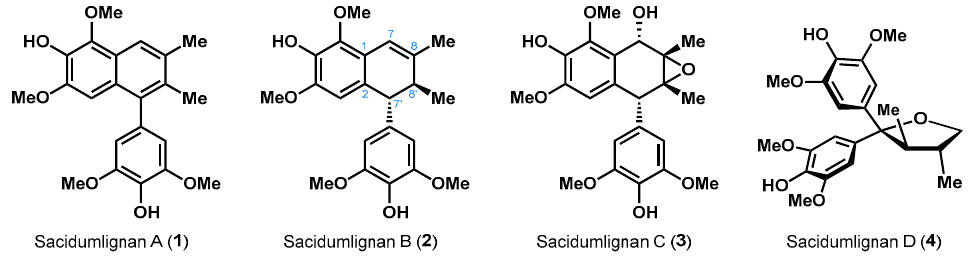
Figure 1. The structures of Sacidumlignans